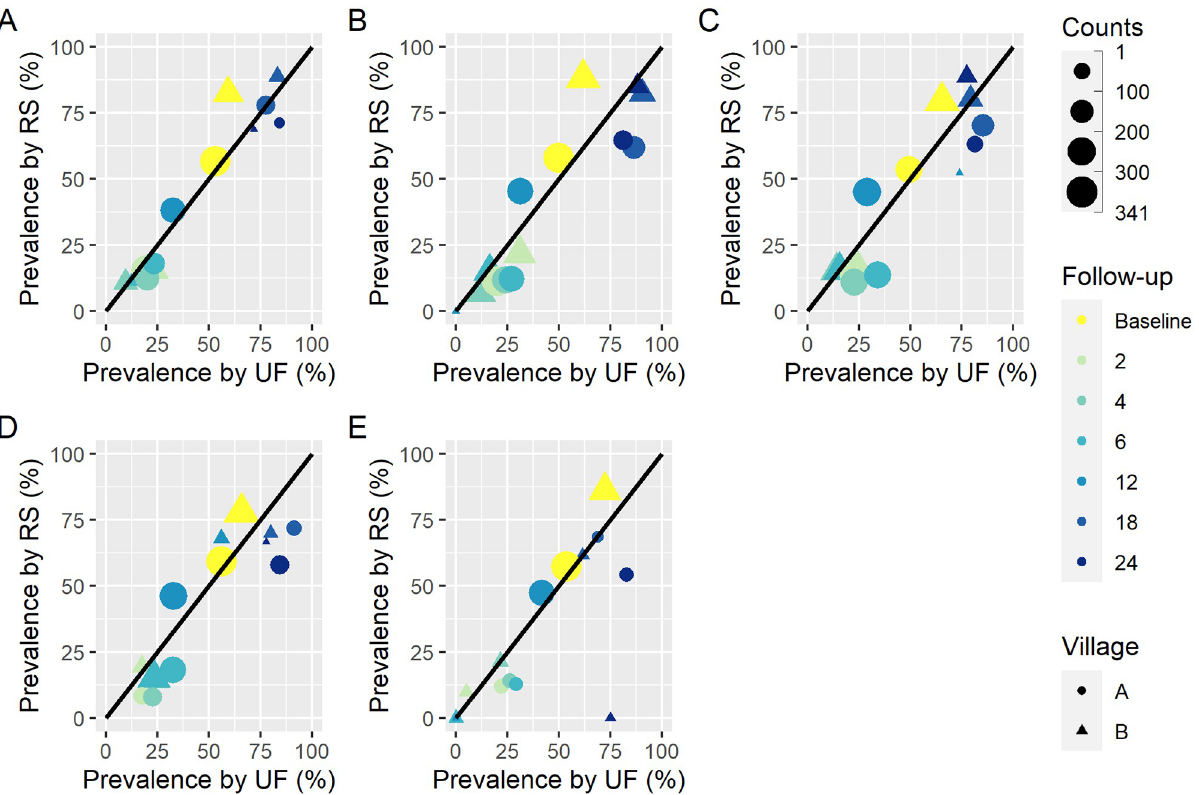
Fig 1. Comparison of prevalence by reagent strip (with trace negative) and urine filtration computed from raw data. The dots and triangles represent the prevalence at baseline (before treatment) and follow-up (at 2, 4, 6, 12, 18, and 24 months post-treatment) for each study site and ‘Counts’ show the number of individuals tested. A shows the prevalence computed from individuals with complete data at day 1 regarding reagent strip and urine filtration tests. B, C, D , and E show the same for days 2, 3, 4, and 5, respectively.